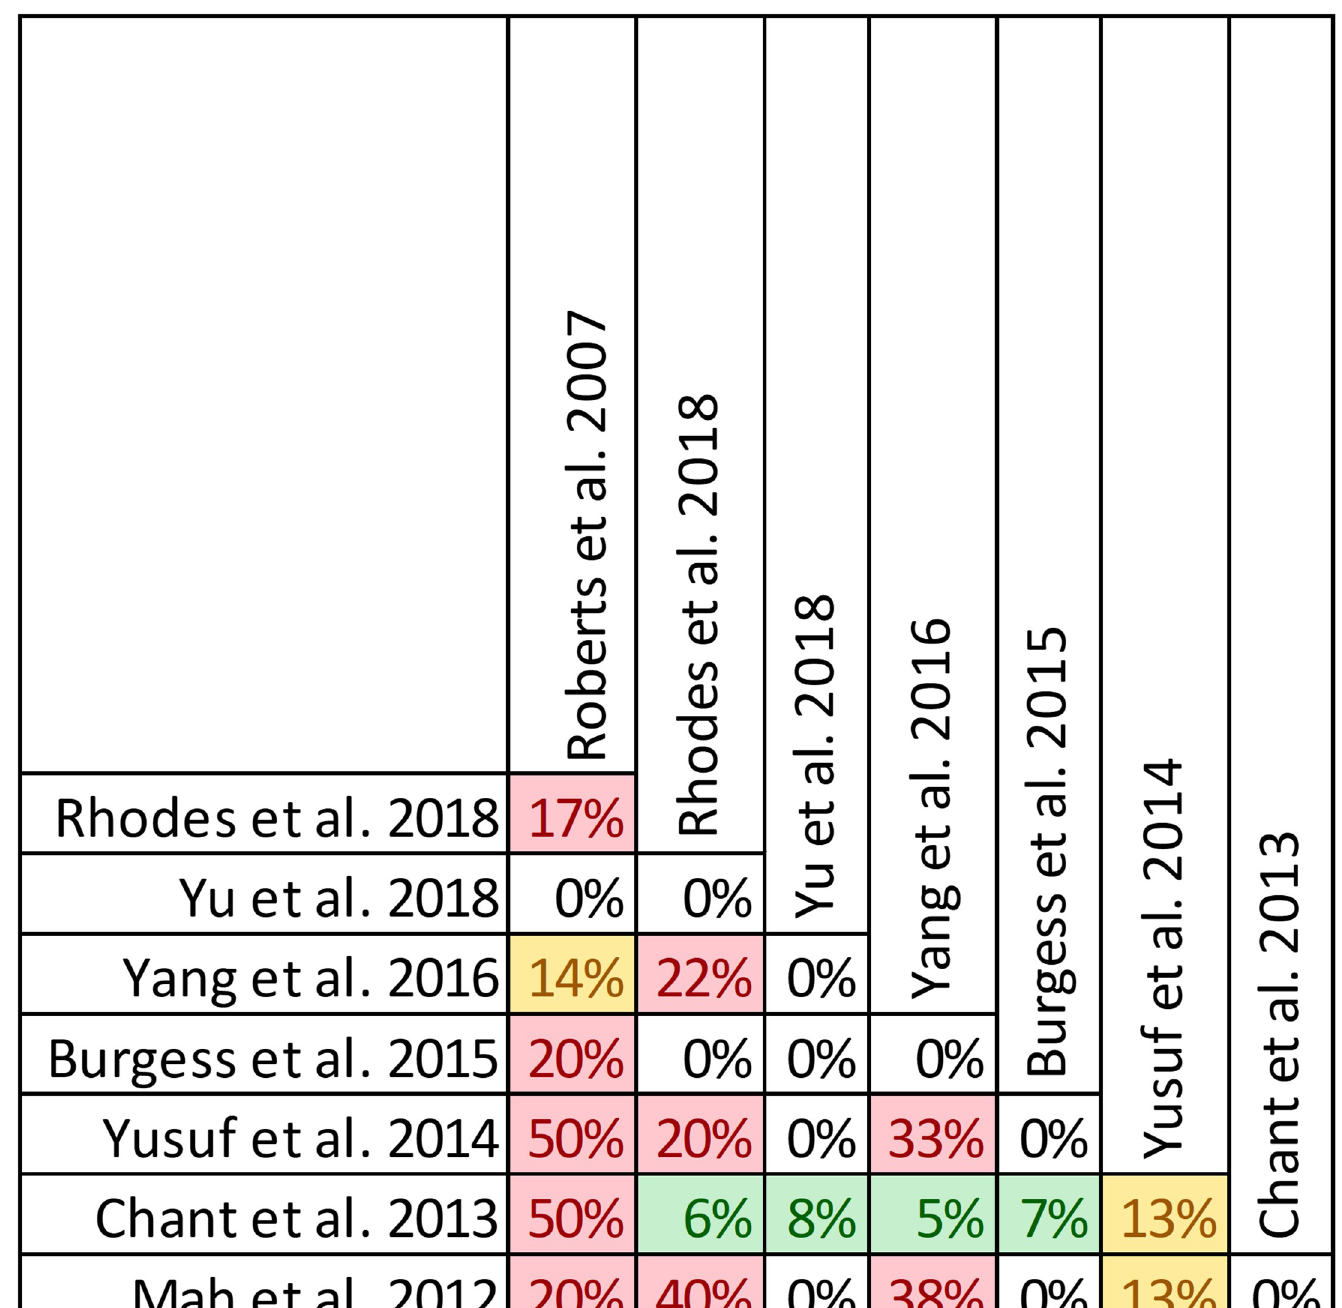
Fig 13. Pairwise CCA for reviews reporting length of stay of prolonged versus intermittent infusions of beta-lactams. Colors indicate degree of overlap, as calculated with CCA, for visual clarity. White = � 5%, green 5.1–9.9%, yellow 10–14.9%, red � 15%.